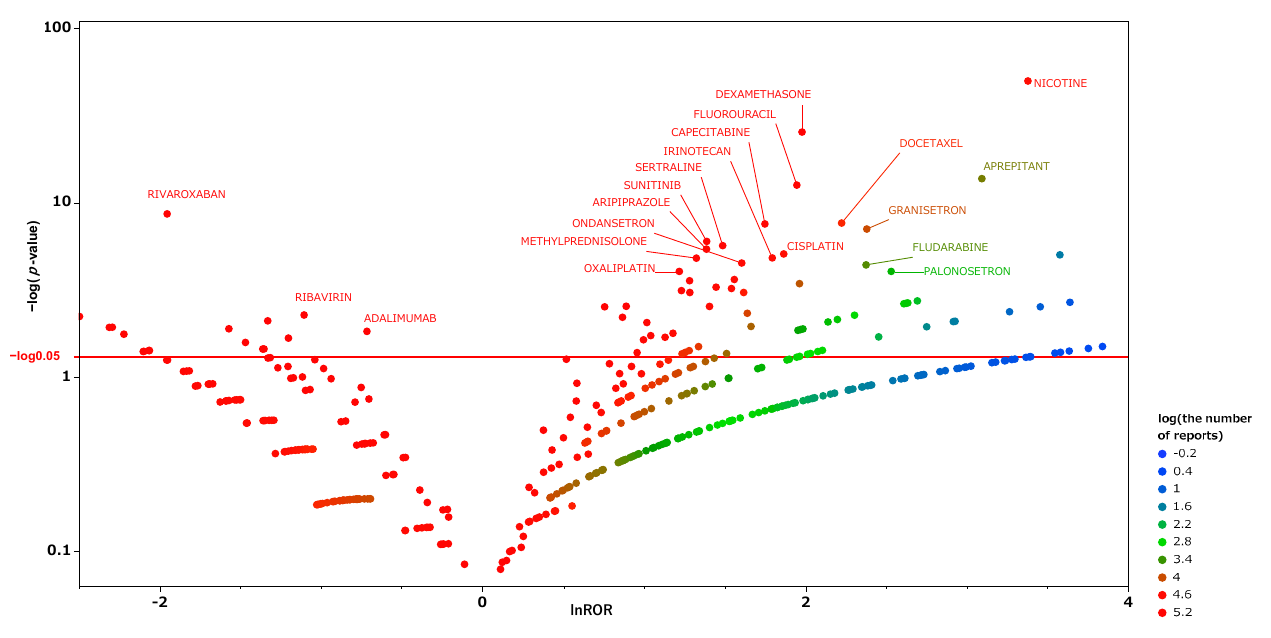
Figure 4. The same as Figure 3, except that this is a scatter plot for the male table.